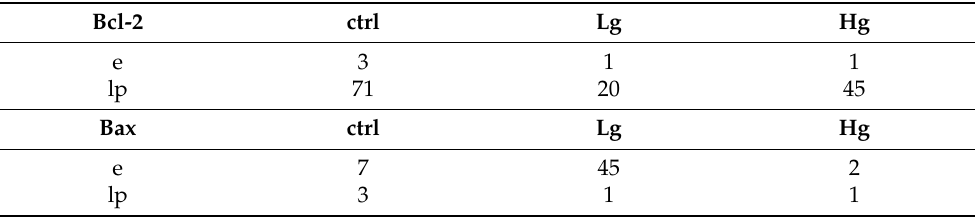
Table 1. Quantification of the positively stained cells in the two regions of interest in the epithelial tissue and the lamina propria of the samples and control group.